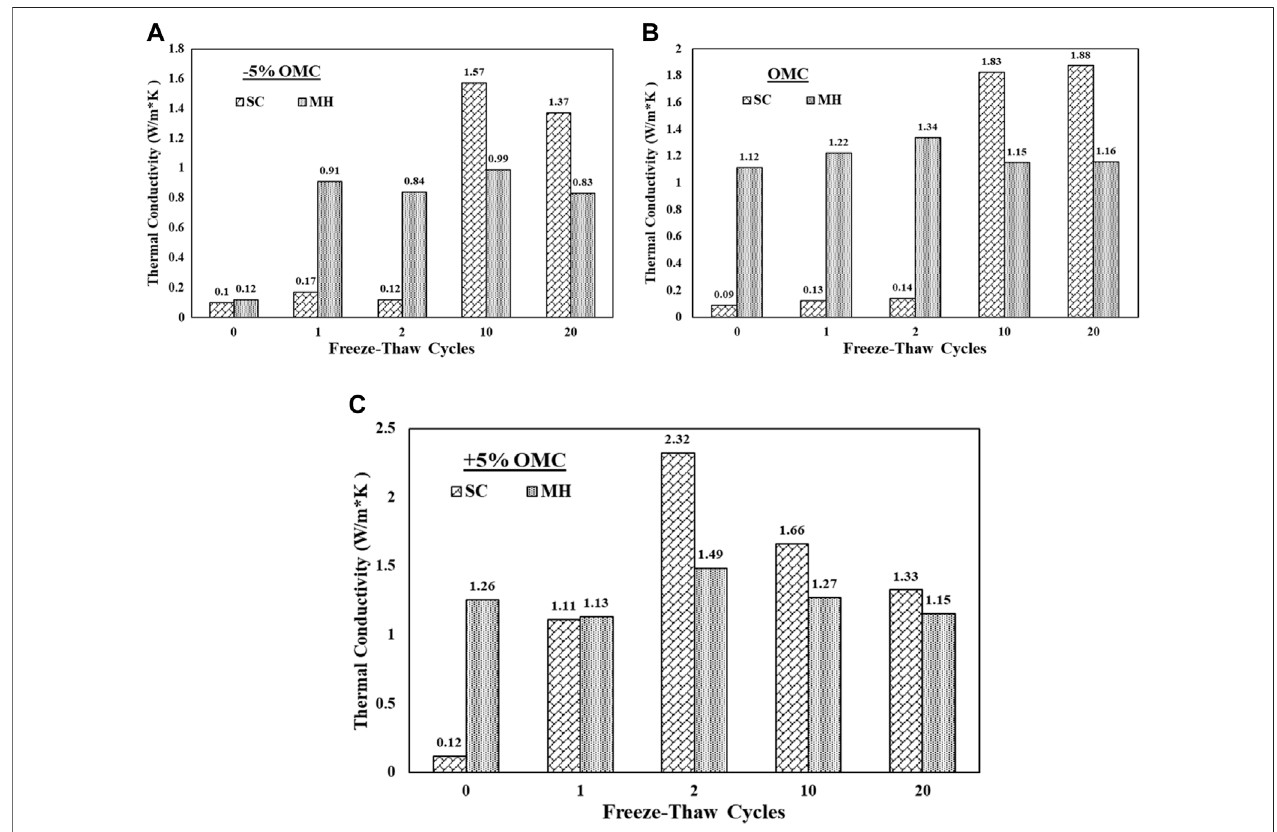
FIGURE 11 | In fl uence of freeze – thaw cycles on thermal conductivity of MH and SC soils prepared at (A) − 5% OMC; (B) OMC; (C) +5% OMC.